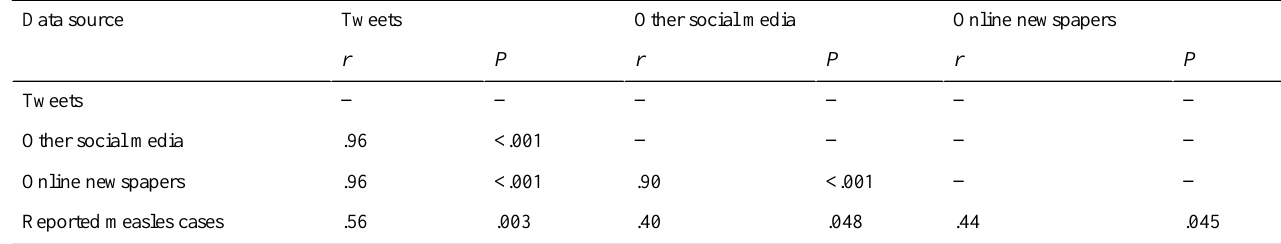
Table 3. Pearson correlations between weekly number of online (social) media messages and weekly number of reported measles cases for the observation period (31 weeks between April 15 and November 11, 2013).